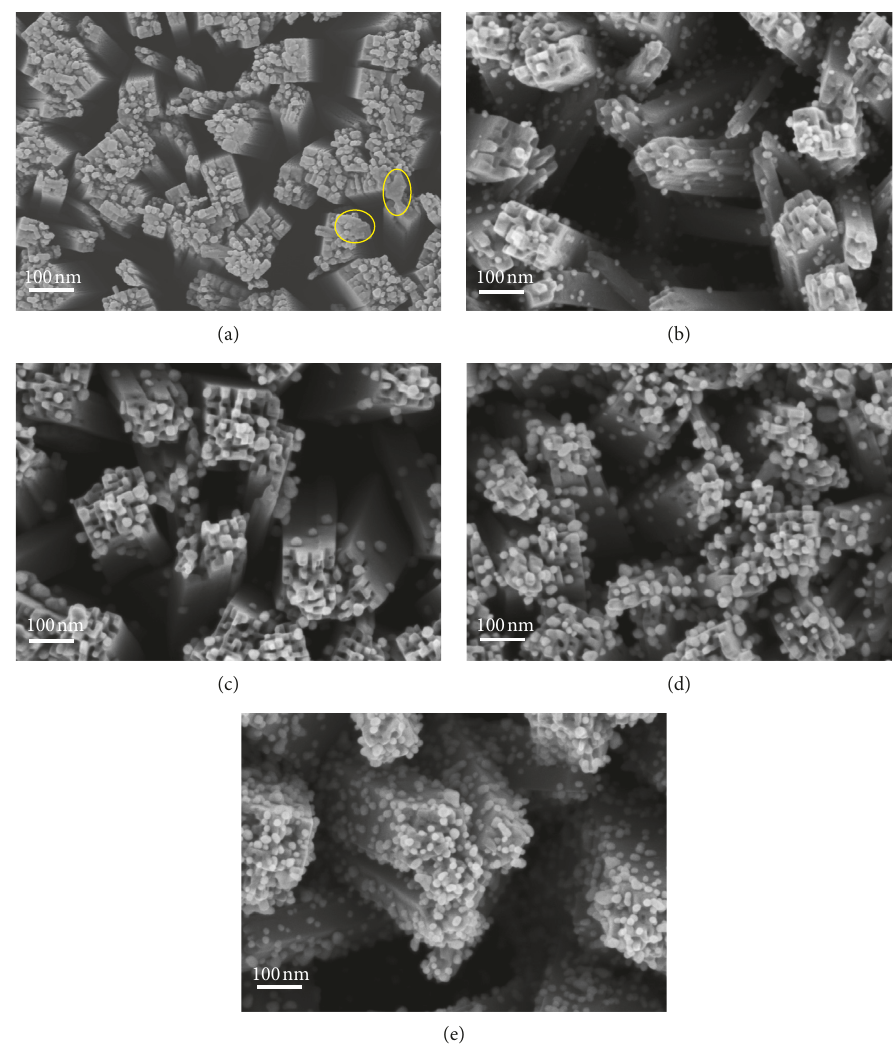
Figure 6: (a) FESEM images of Au-NPs decorated by physical sputtering method. FESEM images of Au-NPs decorated on TiO with (b) 1.0 ×